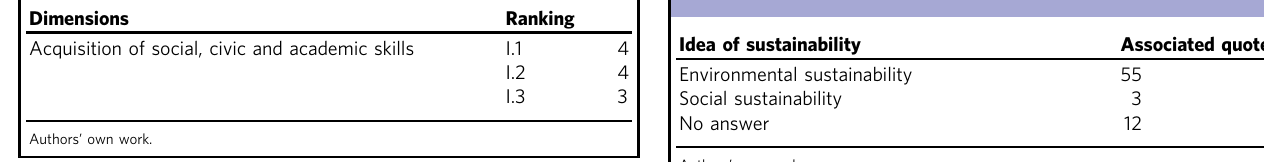
Table 17 Description of sustainability.